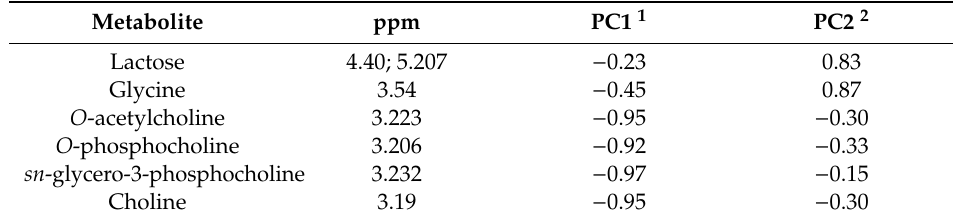
Table 4. Most correlated metabolites of swine colostrum obtained from the principal component analysis carried out on the assigned metabolite matrix.